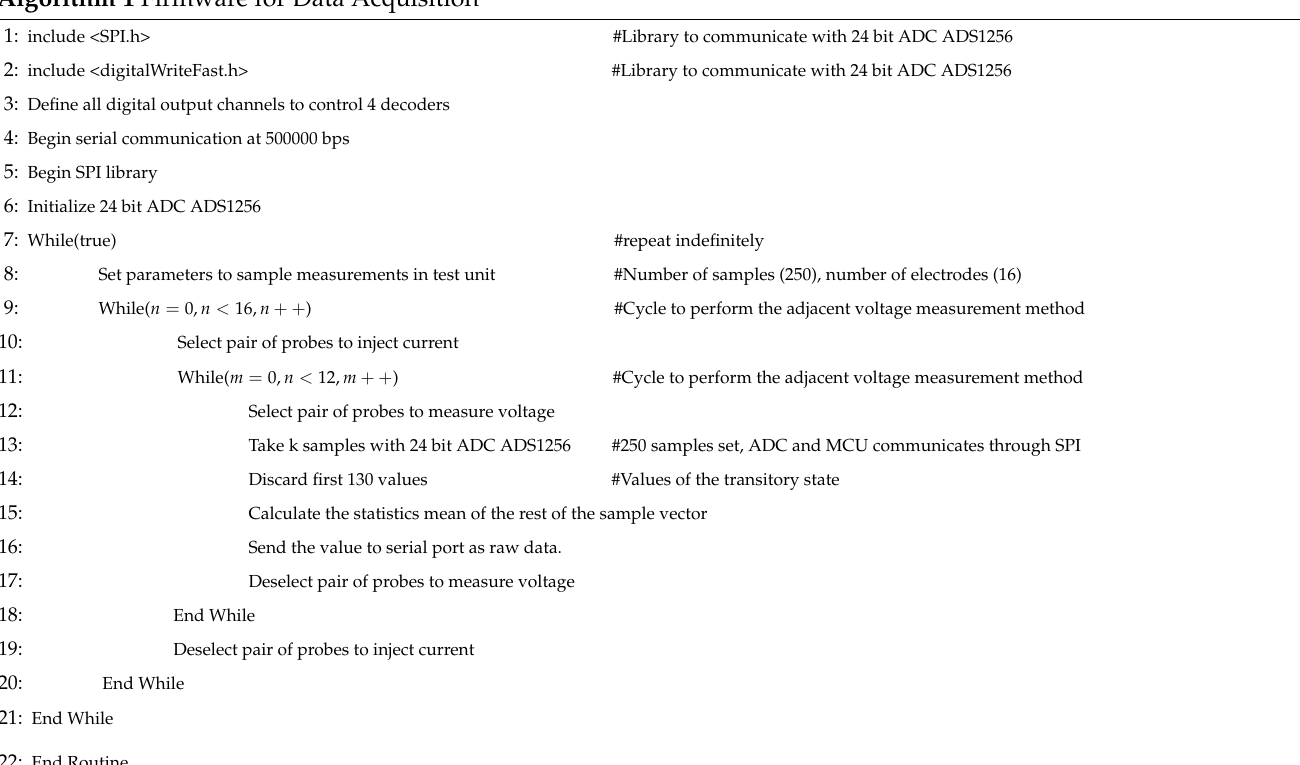
Algorithm 1 Firmware for Data